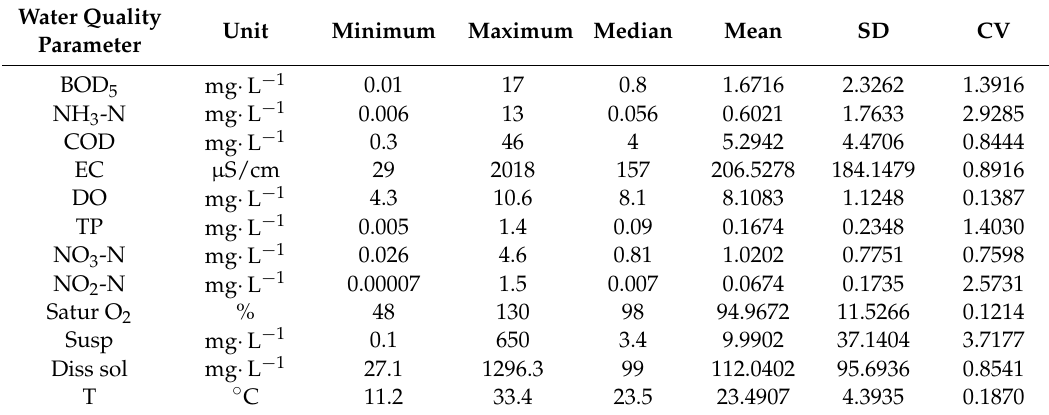
Table 1. Statistical description of water quality parameters across the sample